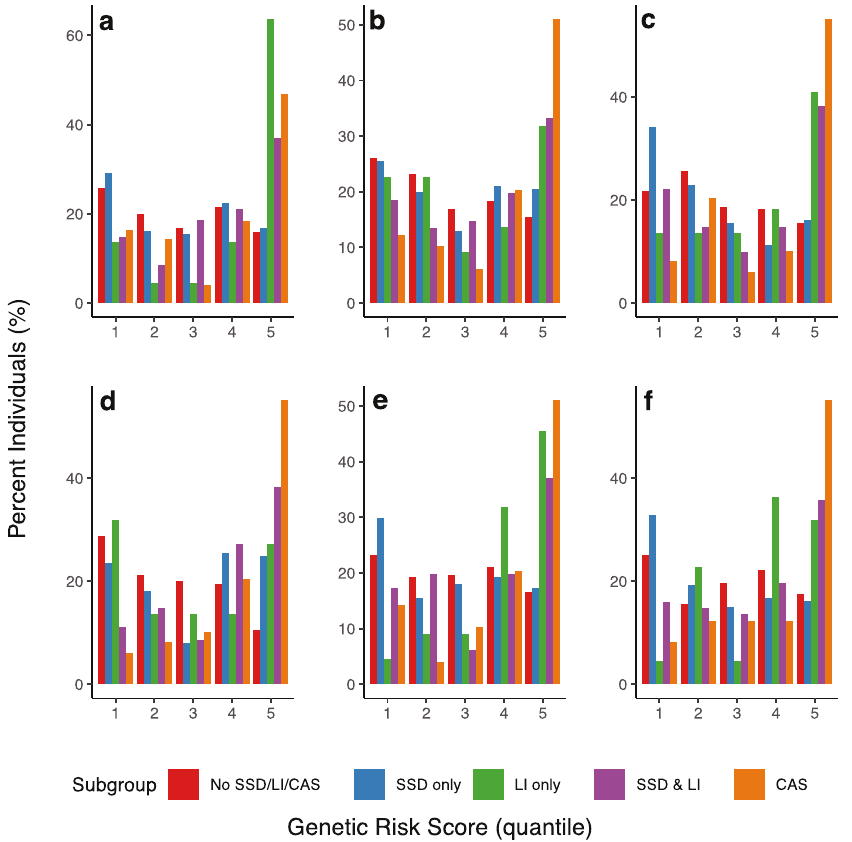
Fig. 3 Polygenic risk scores across major domains. We constructed polygenic risk scores for 587 individuals who were both genotyped and had clinical subgroup information available. Polygenic risk scores are displayed by quantile across the clinical subgroups for six endophenotypes representing the major domains ( a Receptive language; b Expressive vocabulary; c Phonological awareness; d Phonological memory; e Spelling; f Reading